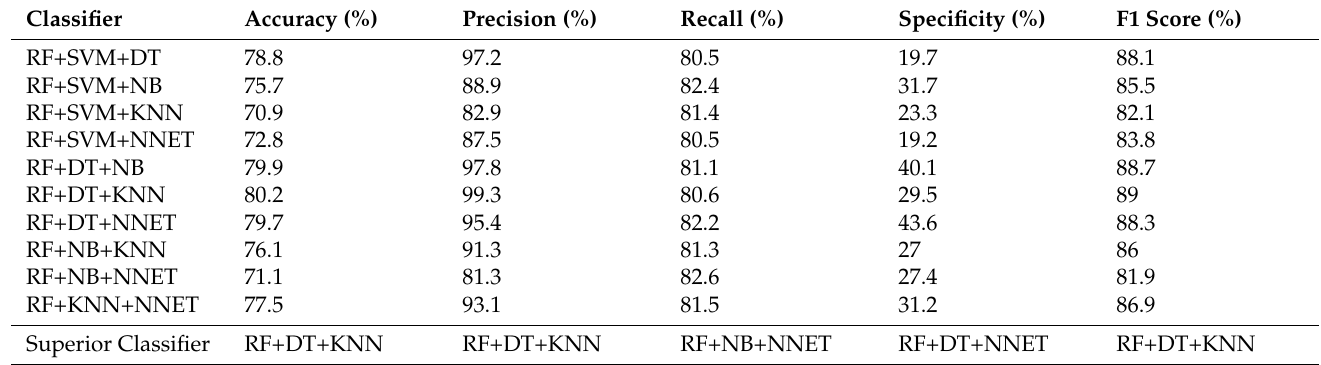
Table 5. Performance comparison of the ensemble classifiers approaches on the KNN imputed dataset.